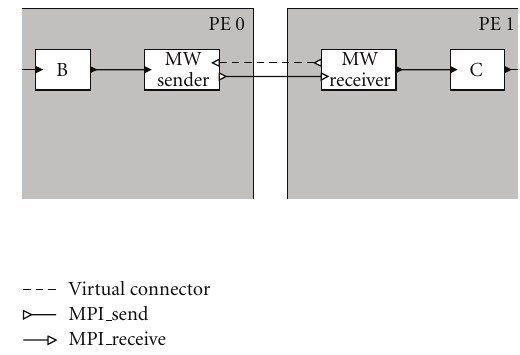
Figure 3: Middleware details for the connector between B and